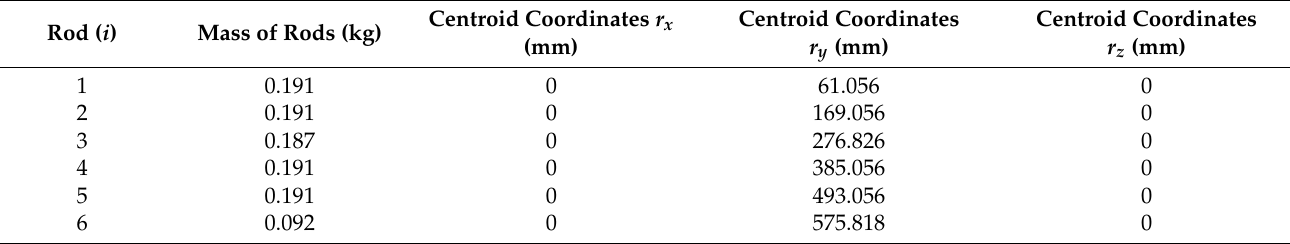
Table 2. The mass and centroid coordinates of each rod of the